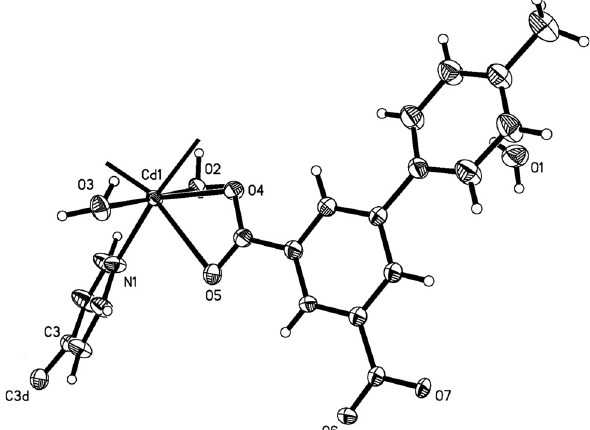
Table  : Data collection and